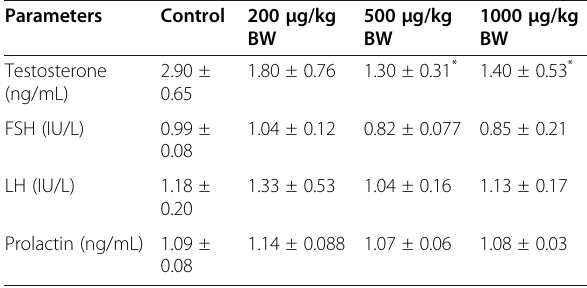
Table 4 Effect of dichloromethane fraction of Waltheria indica Linn . root on reproductive hormones of male Wistar rats (Mean ± SD, n = 5 for each group) Parameters